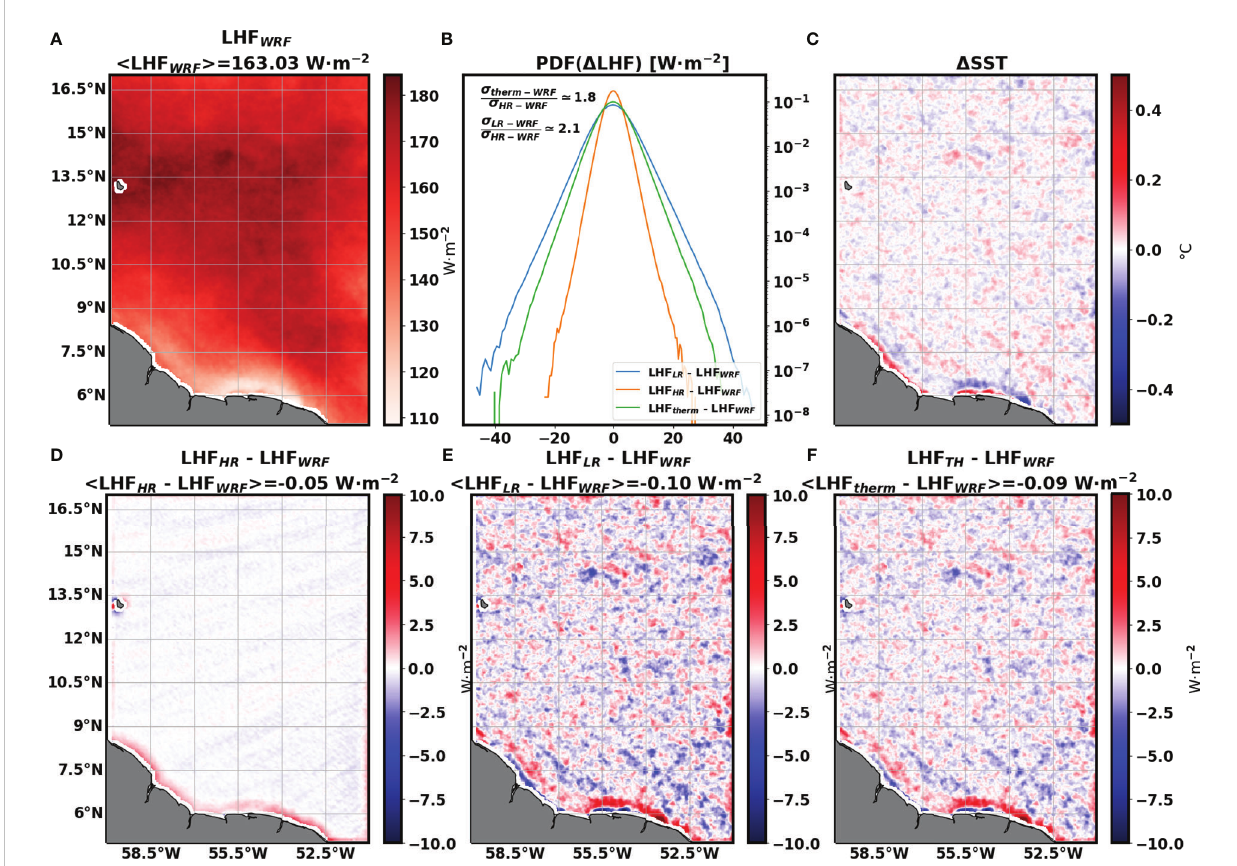
FIGURE 8 Validation with WRF data. In the fi gure, LHFs are all computed by means of the COARE3.5; LHF WRF is the LHF computed from WRF atmospheric and oceanic outputs, LHF LR represents the LHF computed from upscaled WRF data (using a Gaussian fi lter with s = 24 km) and LHF HR stands for the LHF data set computed after having applied the downscaling technique to q 2m , U 10m , T 2m and SST. LHF therm represents the only thermodynamic contribution to LHF, obtained from the correction of T 2m and SST with D SST. (A) Map of mean LHF WRF . (B) PDF of LHF LR - LHF WRF (blue curve), LHF HR - LHF WRF (orange curve) and LHF therm - LHF WRF (green curve). (C) Map of mean SST correction ( D SST). (D-F) Maps of the mean difference between LHF HR , LHF LR , LHF therm (respectively) and the reference LHF WRF . All the means are computed over JF and the 10 members of the WRF